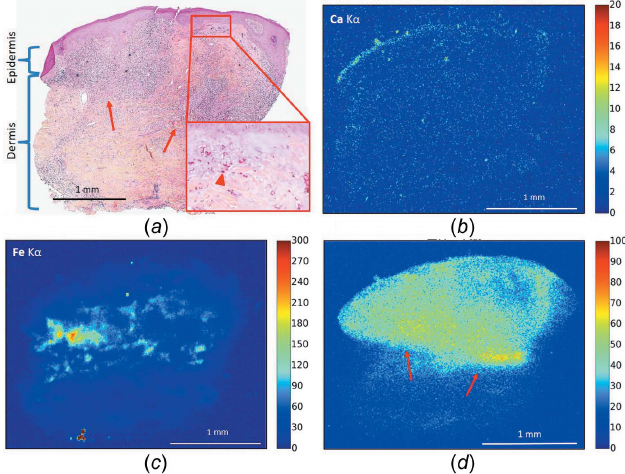
Figure 2 Optical microscopy and XRF maps (patient 2). ( a ) Optical microscopy showing red ink (higher magnification, arrow heads) in the superficial and deep dermis and a diffuse inflammatory infiltrate in the upper dermis (arrows: lower limits of the inflammatory infiltrate), HES-stained ( (cid:4) 40 and (cid:4) 400). ( b , c , d ) Spatial repartition of Ca, Fe and Zn based on the intensity of the XRF K (cid:2) emission. ( d ) Arrows point to the lower limits of the inflammatory infiltrate, in correlation with panel ( a ). The XRF map was acquired at 10 keV using a 10 m m step size and fast acquisition time (80 ms).